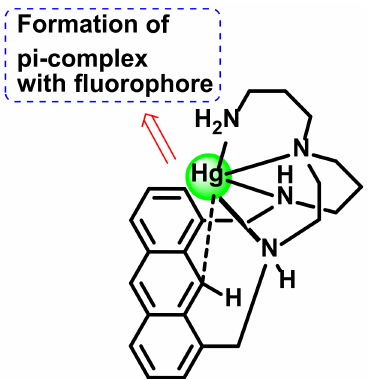
Figure 10. Possible structure of a mercury (II) complex of the ligand that leads to quenching of the fluorescence via formation of a π complex between Hg 2+ and the anthracenyl fluorophore. Reproduced with permission from [26] by